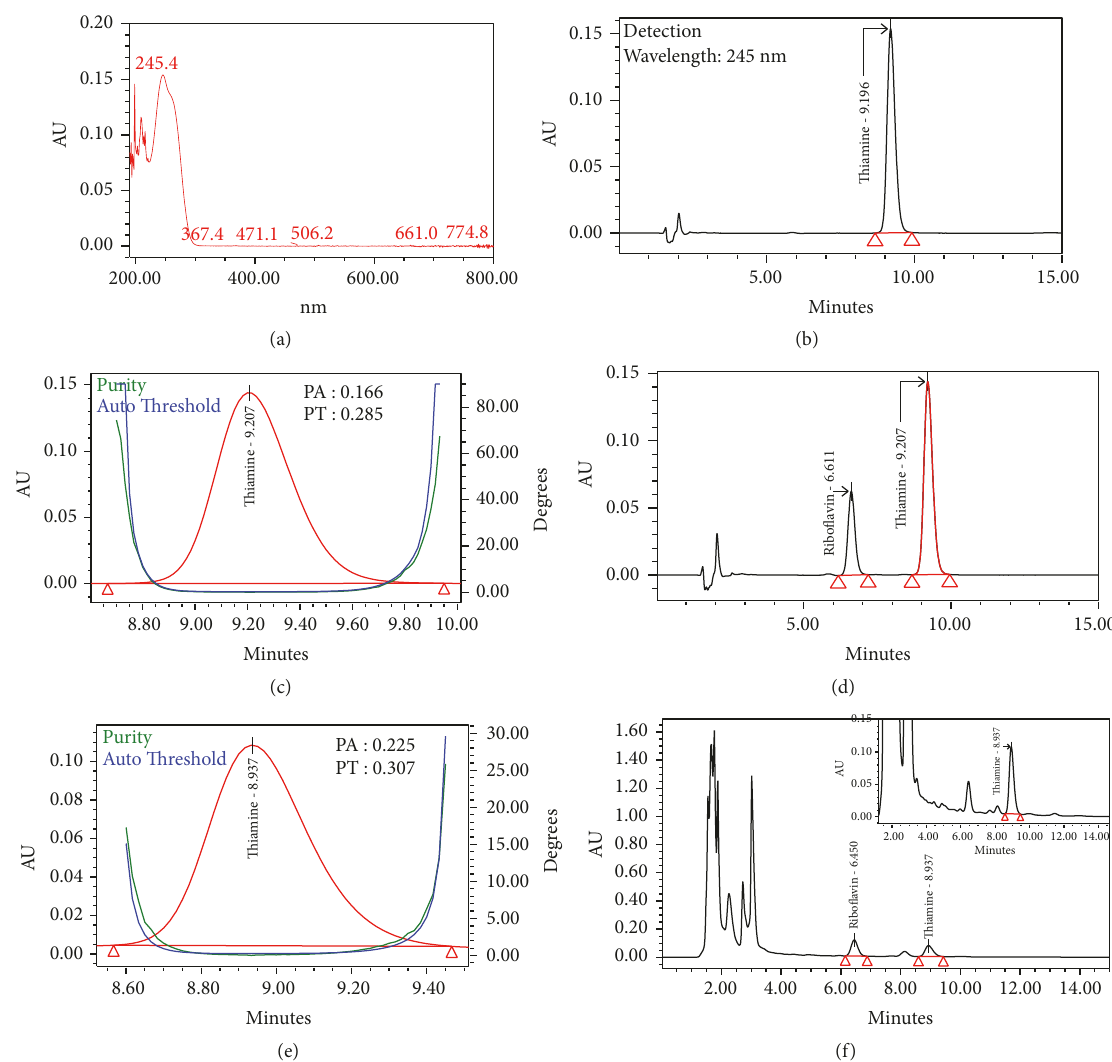
Figure 4: HPLC chromatogramsobtained inpeak identificationand spectralanalysis of thiamine (B1) usingphotodiode arraydetector(PDA, 2996-Waters): (a) absorbance spectra of B2 from 190nm to 800nm, (b) reference standard, (c) purity plot of the B1 in standard solution, (d) reference standards solution, (e) purity plot of the B1 in test sample spiked with reference standards, and (f) test sample spiked with reference